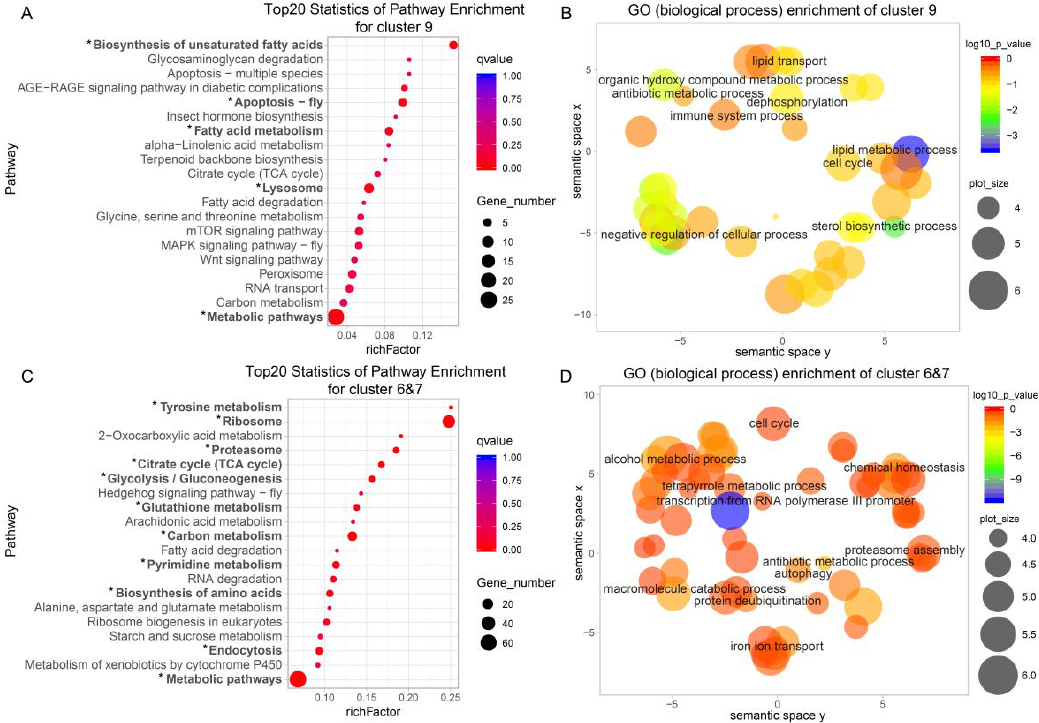
Figure 3. Kyoto Encyclopedia of Genes and Genomes (KEGG) pathway enrichment analysis and gene ontology (GO) classification of high expression genes in the MSG and PSG. ( A , C ) KEGG pathway enrichment analysis of high expression genes in the MSG ( A ) and PSG ( C ), respectively. “*” (qvalue < 0.05) represents a significantly enriched pathway. MSG, middle silk gland; PSG, posterior silk gland. ( B , D ) GO scatterplot constructed with REVIGO for high expression genes in the MSG ( B ) and PSG ( D ), respectively. Colors represent the p -value according to the legend. Bubble size reflects the frequency of each GO term.